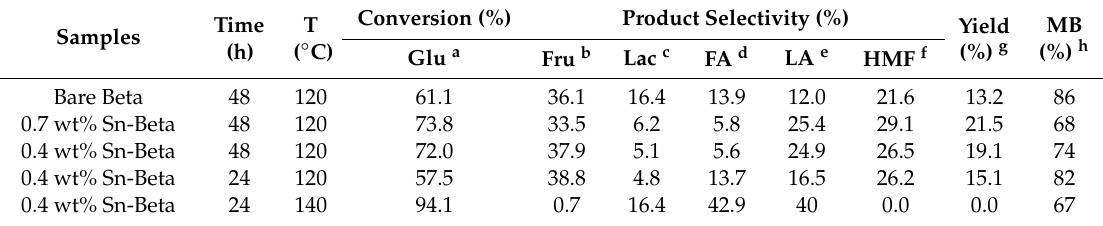
contents obtained at different reaction times and reaction temperatures.